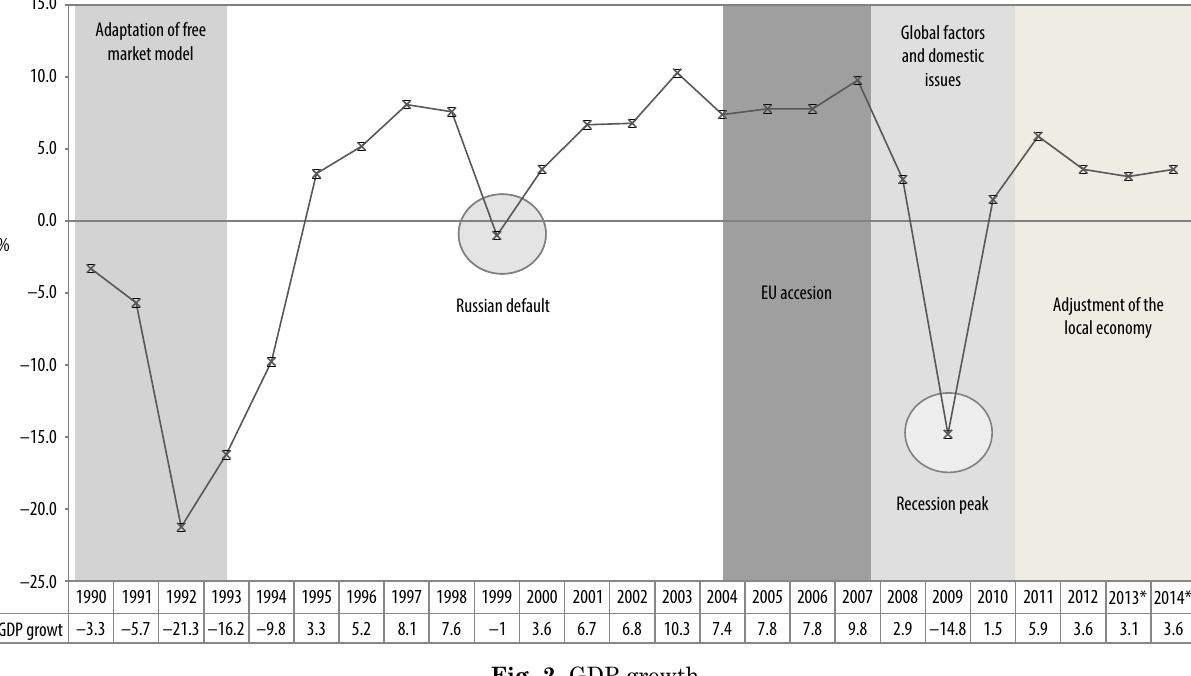
Fig. 2. GDP growth